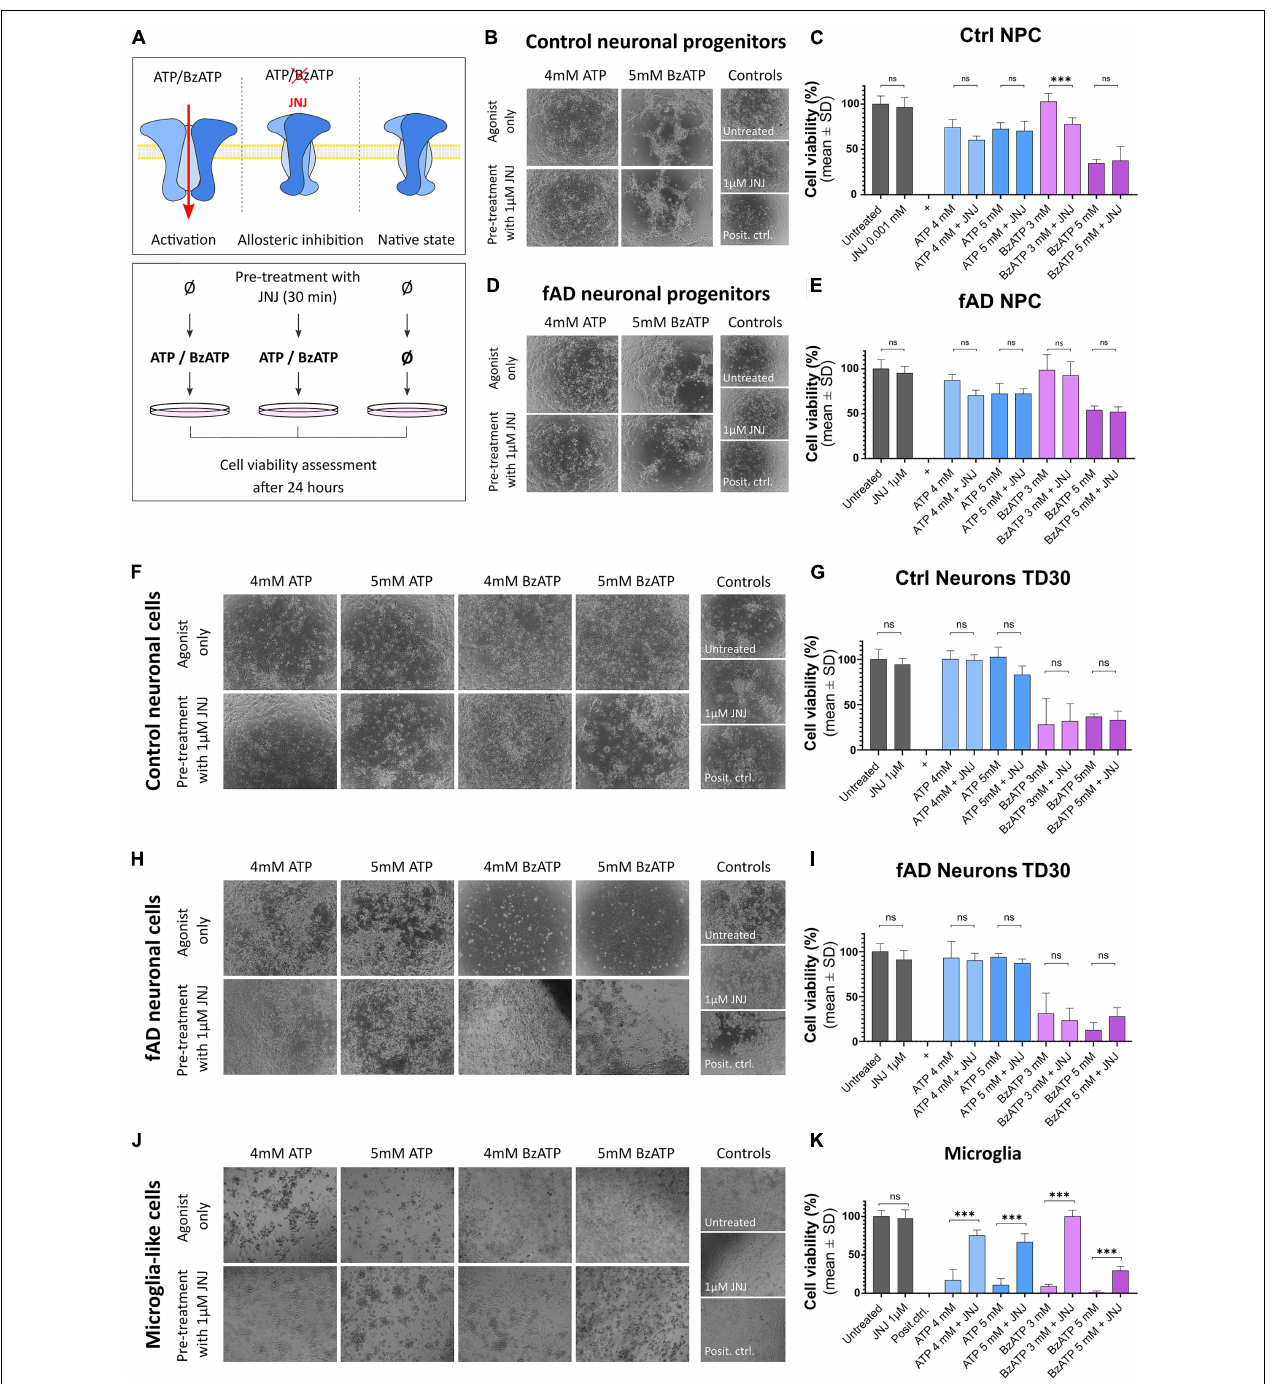
FIGURE 7 | Functional assay results after the application of P2X7R agonists ATP and BzATP alone upon pre-incubation with the highly specific P2X7R antagonist JNJ 47965567. The working concentration of JNJ 47965567 was 1 µ M in all conditions. (A) Outline of the experimental design. Cells were treated for 24 h with ATP or BzATP in different concentrations to promote P2X7R activation; in the samples treated with the P2X7R antagonist JNJ 47965567, the pre-treatment was performed for 30 min before the application of ATP or BzATP to induce blockage of the receptor. Cell cultures were monitored as representative phase-contrast photographs show. Cell viability was measured using PrestoBlue cell viability assay after the treatment in control (B,C) and fAD neuronal pro-genitors (D,E) ; TD35 differentiation stage control (F,G) and fAD neuronal cells (H,I) and microglia-like cells differentiated for 2 weeks (J,K) . In all graphs, the viability of the untreated cells represents 100% viability, and the viability of positive controls (cells treated with water to induce total cell death) represent 0% viability. All the measured values were normalized to the two controls. The presented data are of two independent experiments with each condition performed in triplicate cultures. Error bars represent the mean ± SD. Statistical analysis was performed by ordinary one-way ANOVA followed by Tukey’s multiple comparisons test; p -value ∗∗∗ < 0.001. ns: not significant.